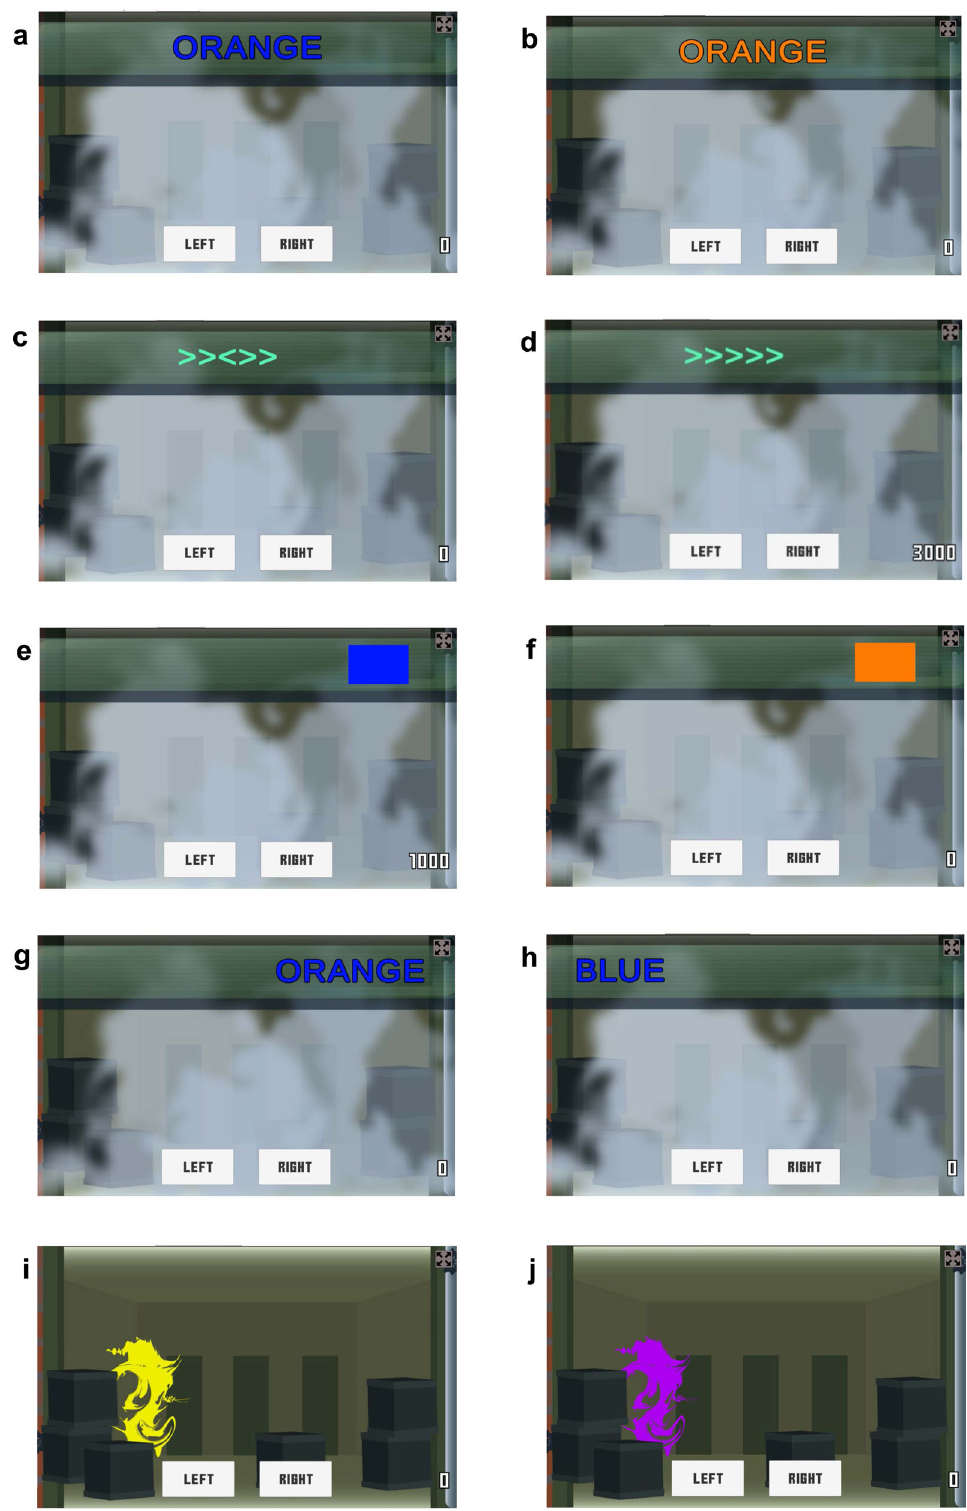
opposite the stimulus. In the Flanker task, fi ne-grained spatially-based attention selection is required between the relevant (target) and irre- levant (distractor) characteristics due to high similarity (e.g., left- vs. right-facing arrows), differing only slightly in terms of their spatial location (central for the target with adjacent distractors